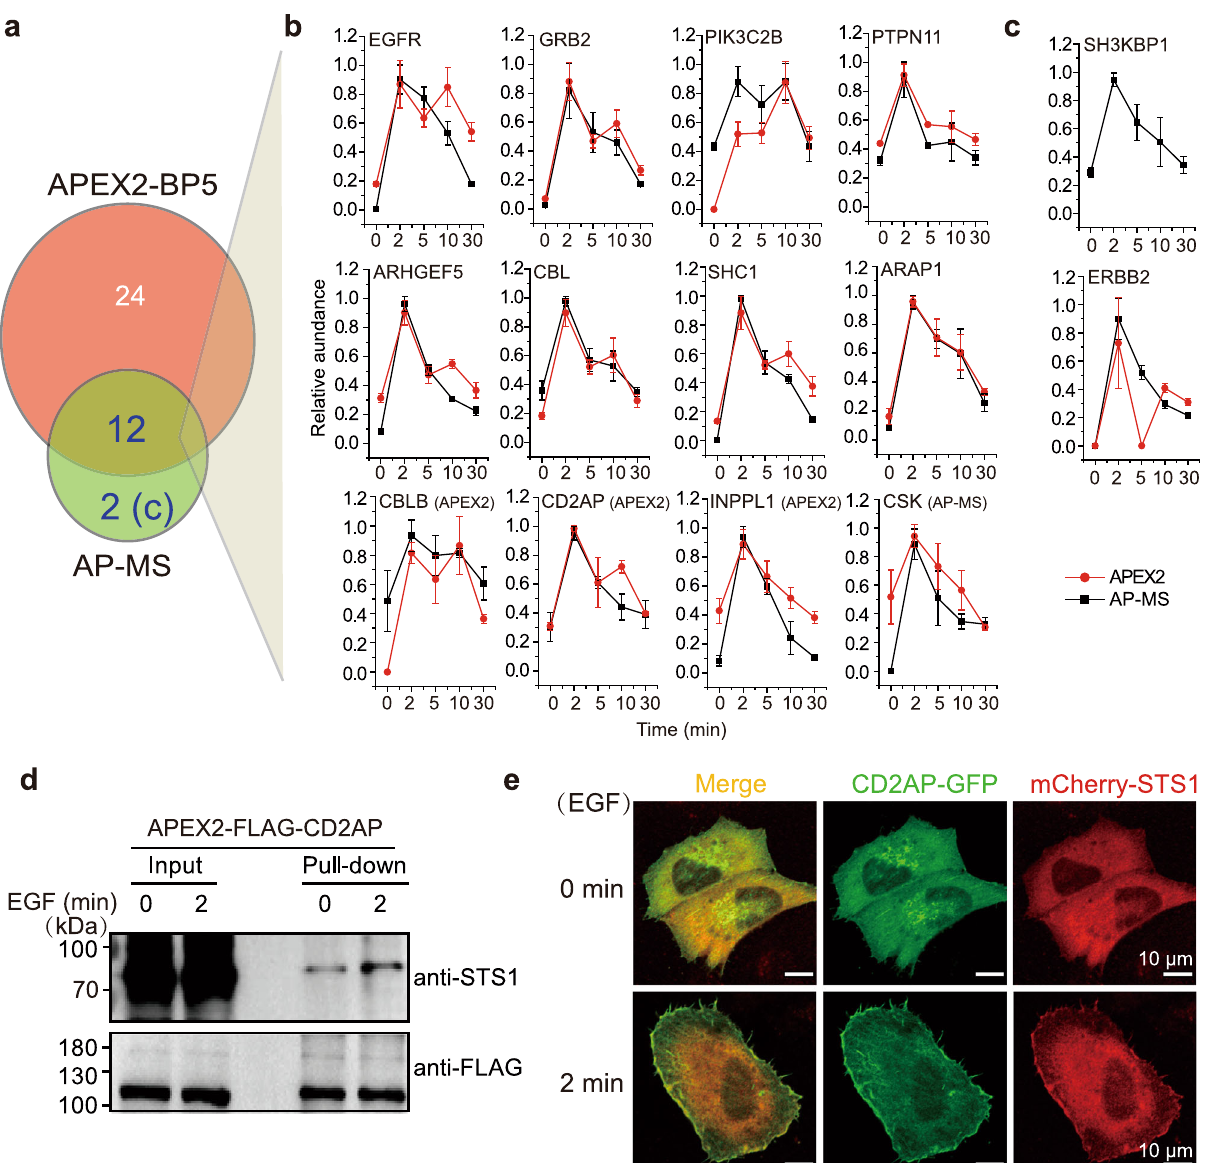
Fig. 5 Comparison with AP-MS con fi rmed the dynamic and weak in vivo interactome of STS1. a Comparison of temporal proteins identi fi ed by BP5- based proximity proteomics and FLAG tag-based AP-MS. AP-MS was performed in the same HeLa cells with stably expressed APEX-FLAG-STS1 and EGF stimulation as indicated in Fig. 4a. b Individual temporal curves of the STS1-interacting proteins identi fi ed in both APEX2-BP5 proximity proteomics and AP- MS. CBLB, CD2AP, INPPL1, and CSK meet the cutoff only in APEX2-BP5 proximity proteomics or AP-MS (as indicated in brackets), but were manually included into overlap part because of their curve similarity. c Individual temporal curves of the STS1-interacting proteins uniquely signi fi cant in AP-MS. Data in b and c are presented as mean values ± s.d. (error bars; n = 3 independent biological experiments). d Validation of CD2AP as an EGF-stimulation- dependent STS1-interacting protein by streptavidin pull-down of stably expressed APEX2-FLAG-CD2AP in HeLa cells and western blots ( n = 3 independent biological experiments). Quanti fi cation was presented in Supplementary Fig. 12d. e Colocalization of transiently co-transfected GFP-tagged CD2AP and mCherry-tagged STS1 in HeLa cells upon EGF stimulation ( n = 3 independent experiments). The scale bars are 10 µ m. Results were quantitatively con fi rmed by line pro fi le analysis shown in Supplementary Fig. 12b. Source data are provided as a Source Data fi